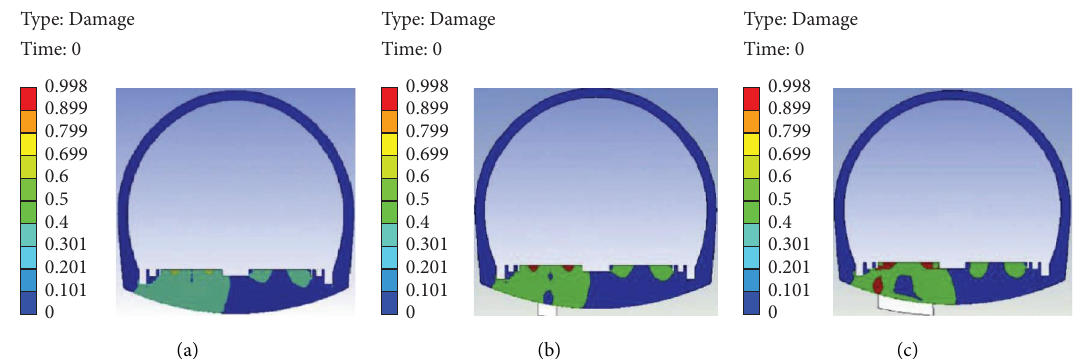
Figure 21: Distribution characteristics of substructure damage in three stages of surrounding rock in the 20th year of operation: (a) denser; (b) local cavity; (c) cavity